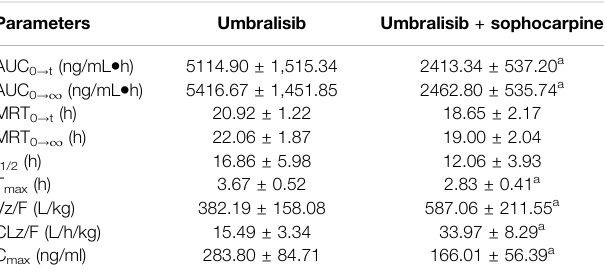
a Represents p < 0.05.